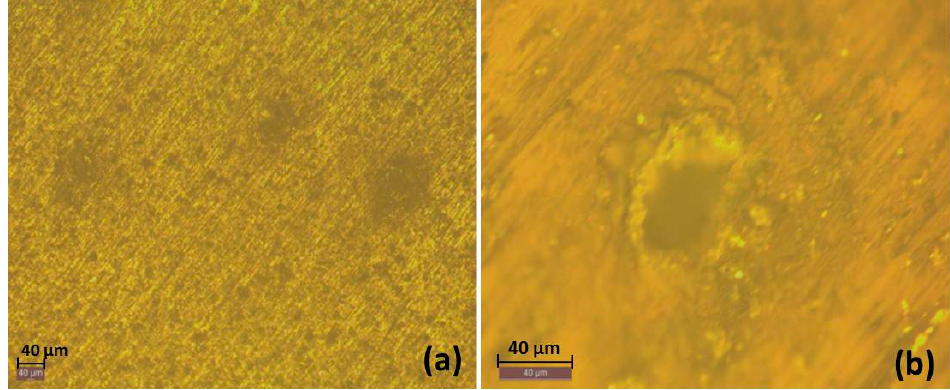
Figure 16. Optical images of HA coating surface after 10 days of immersion in 3.5% NaCl solution ( a ) low magnification, ( b ) enlarged magnification.